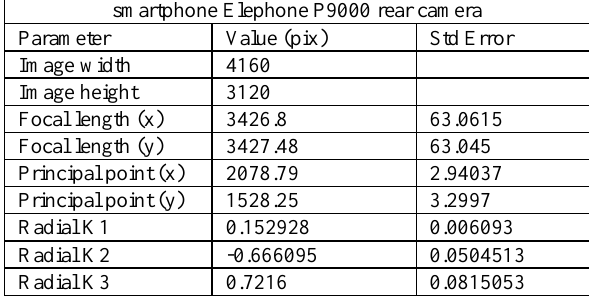
Table 3. Calibration parameters of the smartphone Elephone P9000 rear camera in Agisoft Lens.